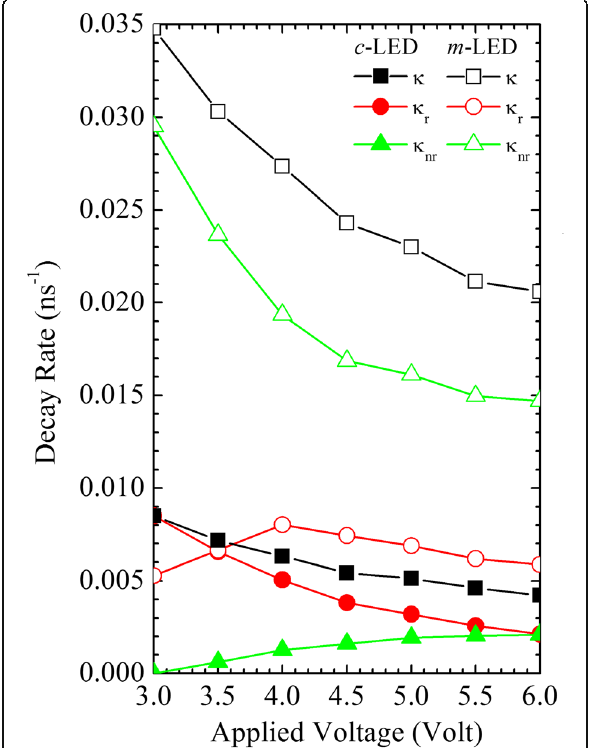
Fig. 6 The total ( κ ), radiative ( κ r ), and nonradiative ( κ nr ) decay rates as functions of applied voltage for the c - ( filled symbols ) and m -LEDs ( unfilled symbols